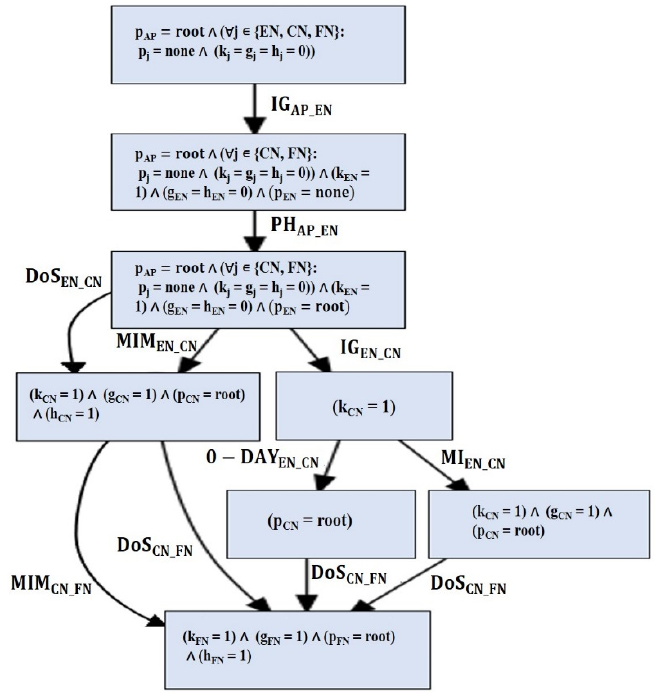
Figure 4 . Attack graph produced for the WTP. Figure 4. Attack graph produced for the